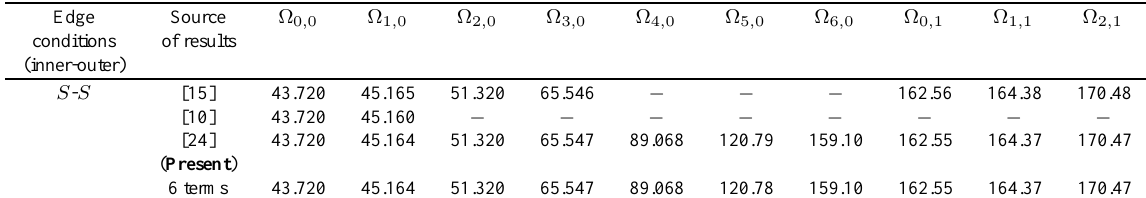
Table 4 Comparison of Ω m,n for polar orthotropic annular plates of uniform thickness when e r = 5 . 0 , g r = 0 . 356 ,ν r = 0 . 06 ,R 0 = 0 . 5 ,K f =